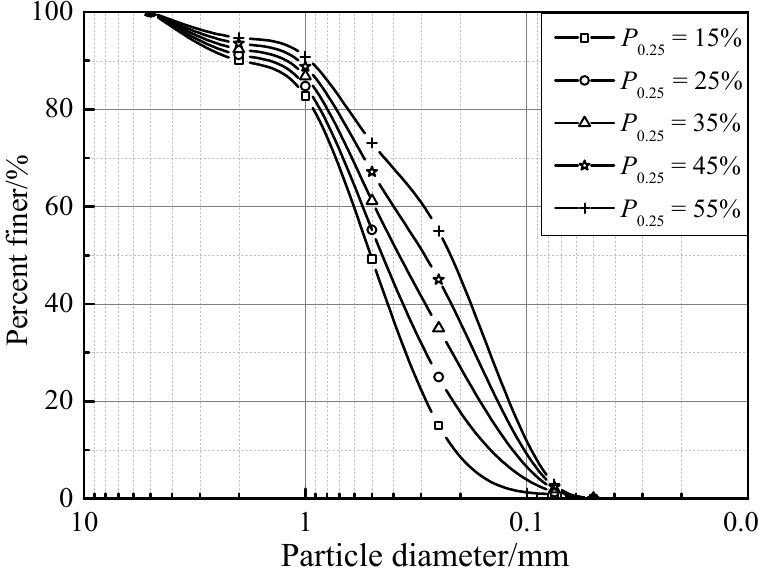
Figure 1. Grain size distribution curve of the tested calcareous sand. Table 2. Basic property parameters of the test sands ( P 0.25 =